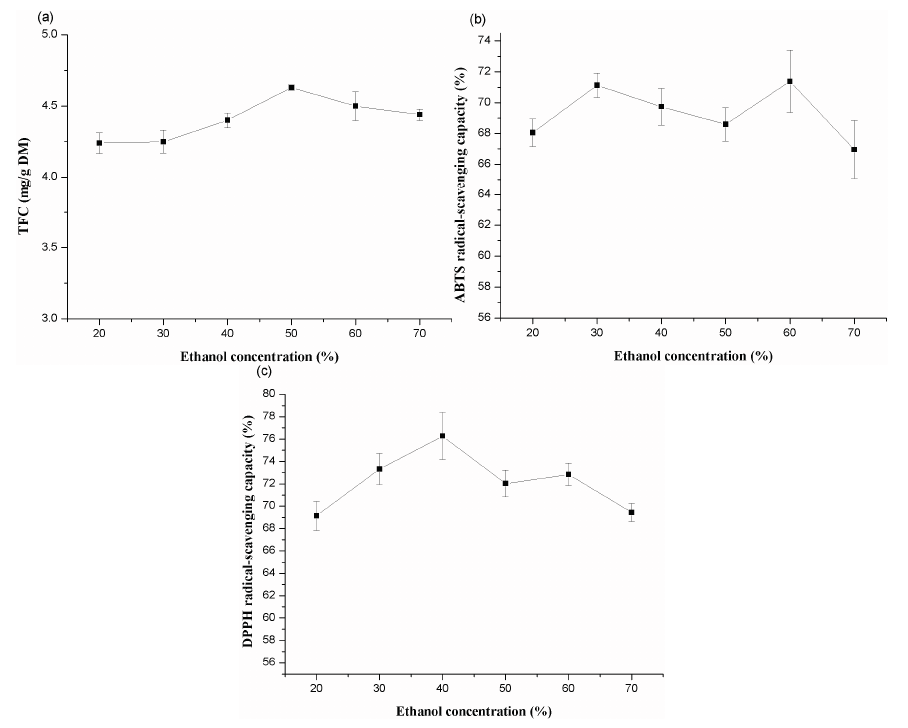
Figure 4. Effects of ethanol concentration on the extraction yield of total flavonoids ( a ); ABTS ( b ) and DPPH ( c ) radical-scavenging capacities of extracts from